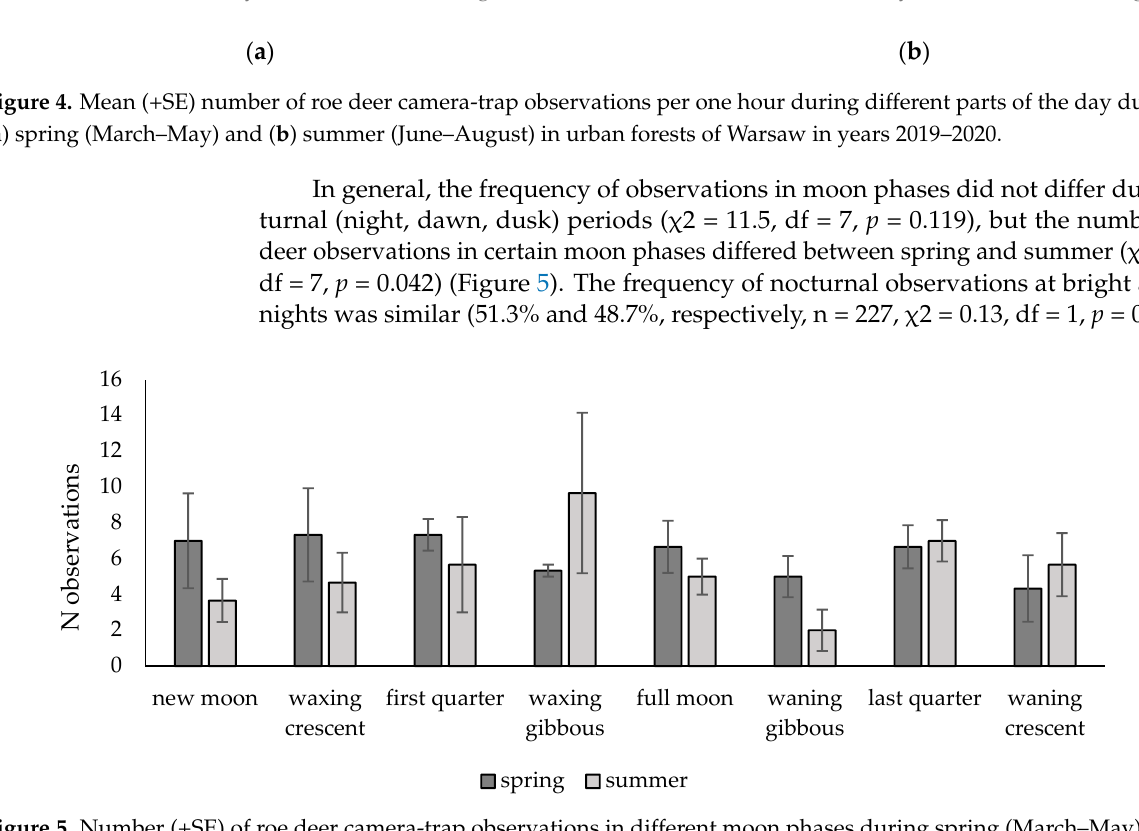
Figure 5. Number (+SE) of roe deer camera-trap observations in different moon phases during spring (March–May) and summer (June–August) in urban forests of Warsaw in years 2019–2020.